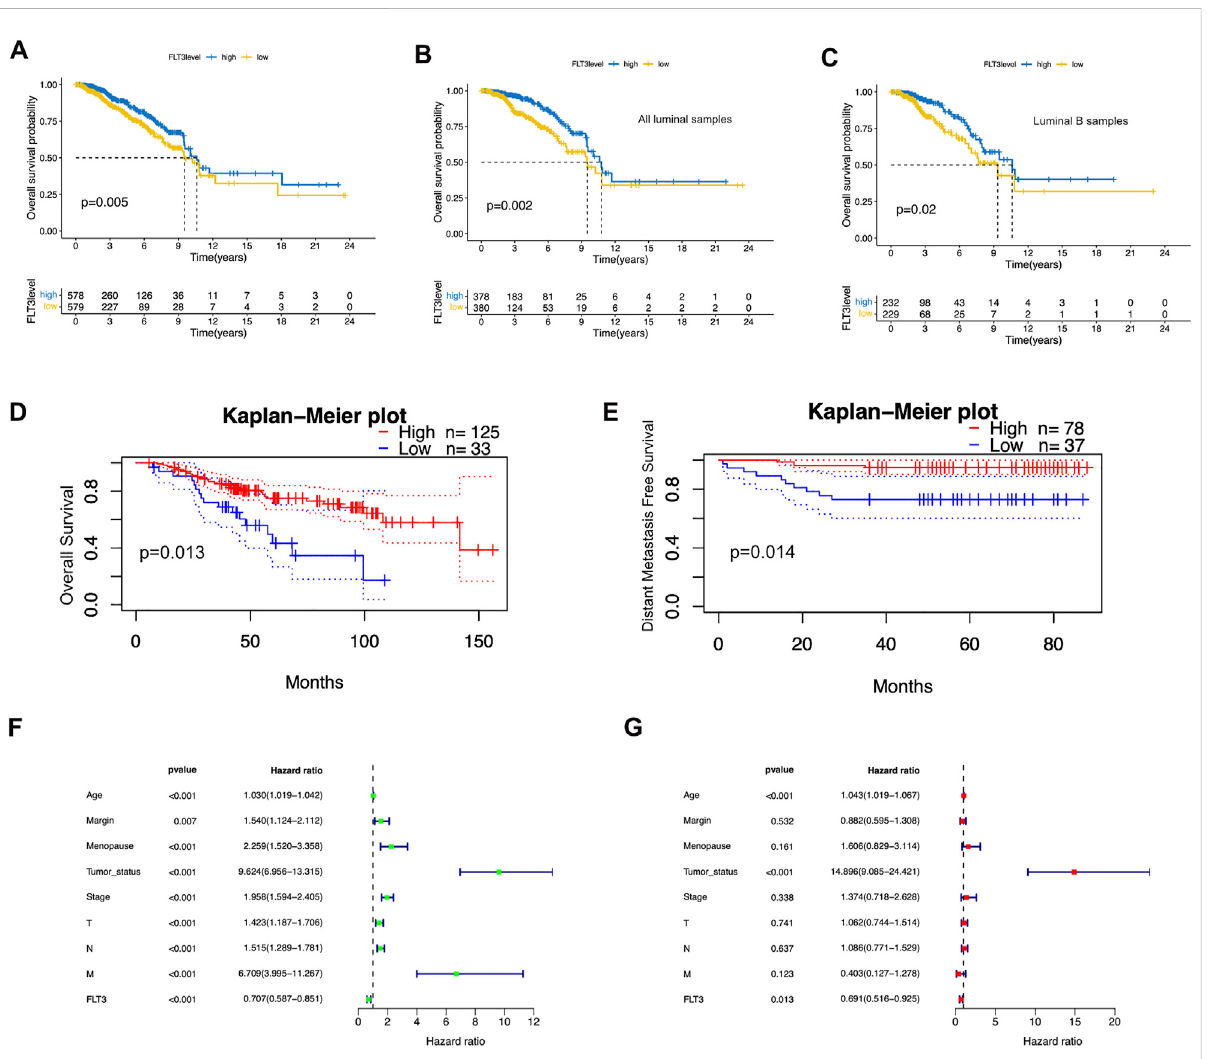
FIGURE 2 Prognostic value of FLT3 expression in BC. (A) High FLT3 expression was associated with a favorable OS in BC patients using Kaplan – Meier plotter. (B,C) High FLT3 expression was inferred as a good OS in all luminal samples and all luminal B samples. (D,E) The upregulation of FLT3 infers longer OS and DMFS on the website of prognoscan. (F,G) Forest plots show the association between FLT3 expression and clinicopathological features using univariate and multivariate COX hazard